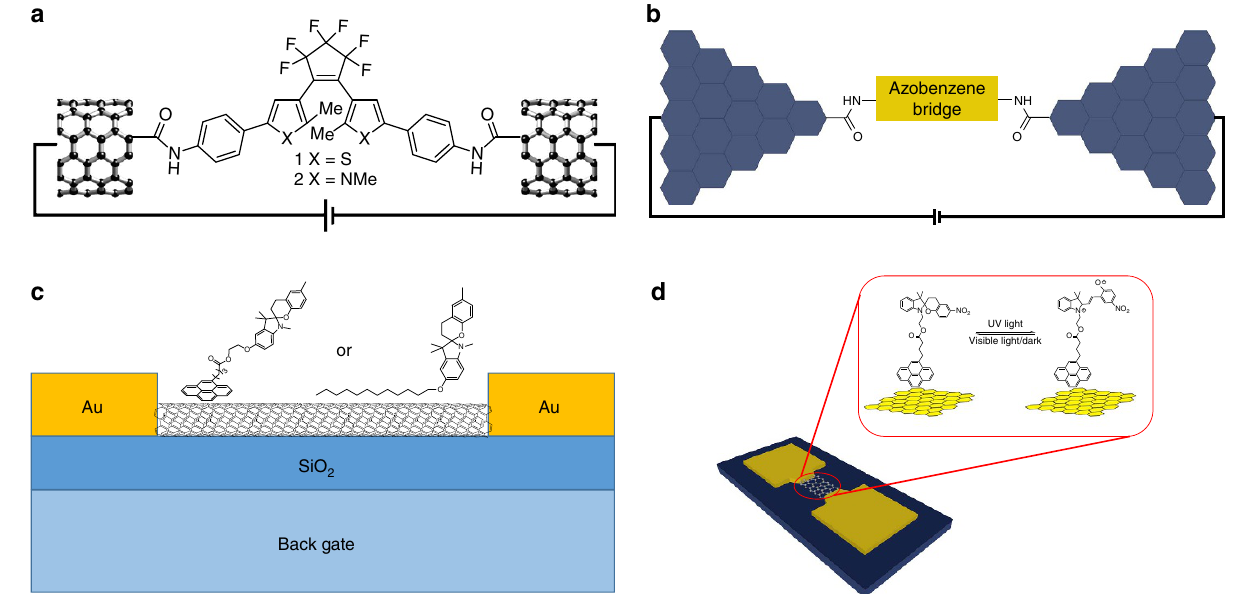
Figure 3 | Applications of photochromic carbon-based nanomaterials in molecular junctions (upper images) and transistors (lower images). Amide formation is used ( a ) to bridge two CNTs with a diarylethene molecule. Adapted from ref. 82 (Copyright 2007 American Chemical Society) and ( b ) to connect covalently two graphene point contacts with an azobenzene molecule. Adapted from ref. 84 (Copyright 2013 John Wiley & Sons, Ltd.). ( c ) Spiropyrans derivatized with either alkane or pyrene groups were physisorbed on CNTs. Adapted from ref. 89 (Copyright 2005 American Chemical Society). ( d ) A graphene-based field-effect transistor functionalized with pyrene-substituted spiropyrans. Adapted from ref. 94 (Copyright 2012 American Chemical